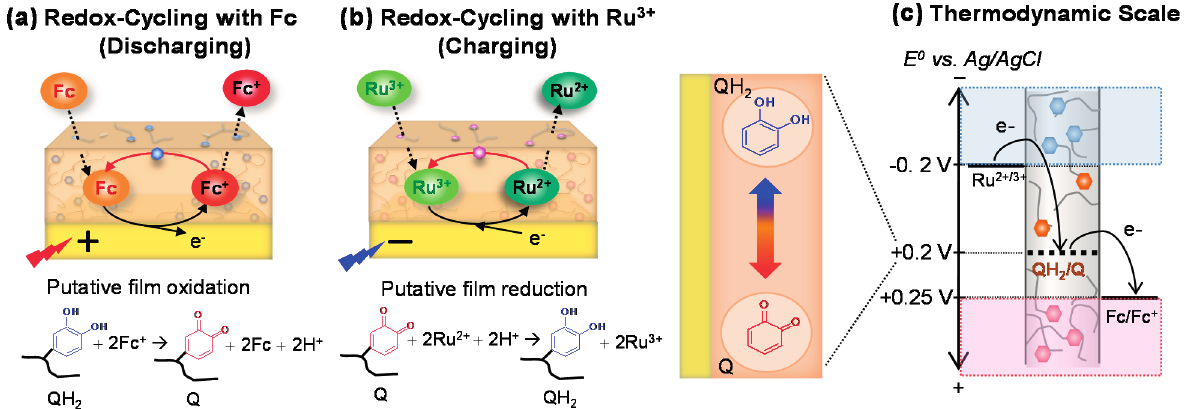
Figure 15. Redox-cycling of the catechol-chitosan redox-capacitor. ( a ) Oxidative redox-cycling can discharge electrons from the film; ( b ) Reductive redox-cycling can charge the films with electrons; ( c ) Thermodynamics controls the direction of electron transfer such that a mediator can only transfer electrons to/from the film in one direction. Reproduced with permission from [233], published by Royal Society of Chemistry,